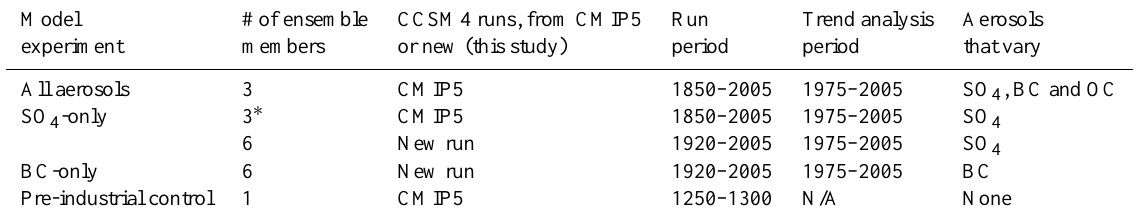
Table 1. List of experiments, number of ensemble members, whether the run with CCSM4 was obtained from CMIP5 or is a new run conducted in this study, run period, trend analysis period and aerosols that vary in the run.